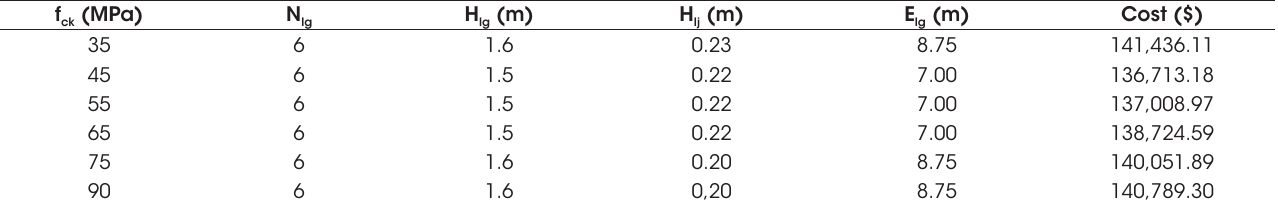
Cost of the deck in function of the characteristic strength of concrete, Group